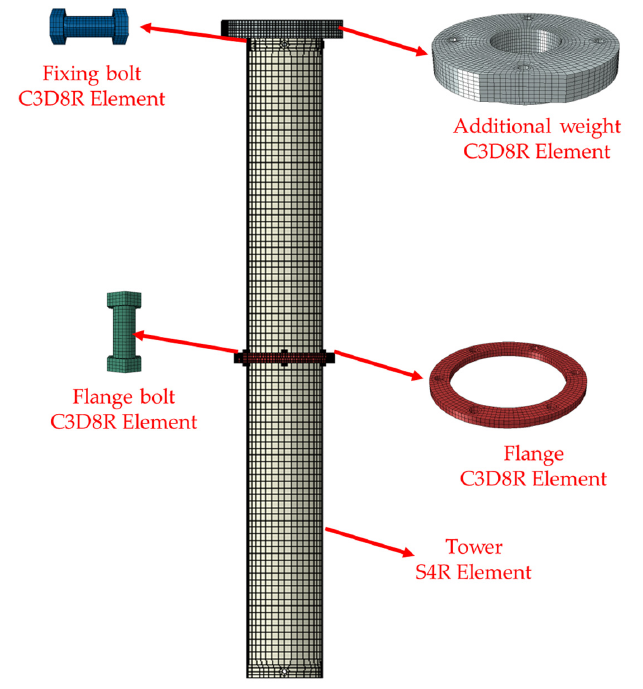
Figure 31. Scale finite element model.